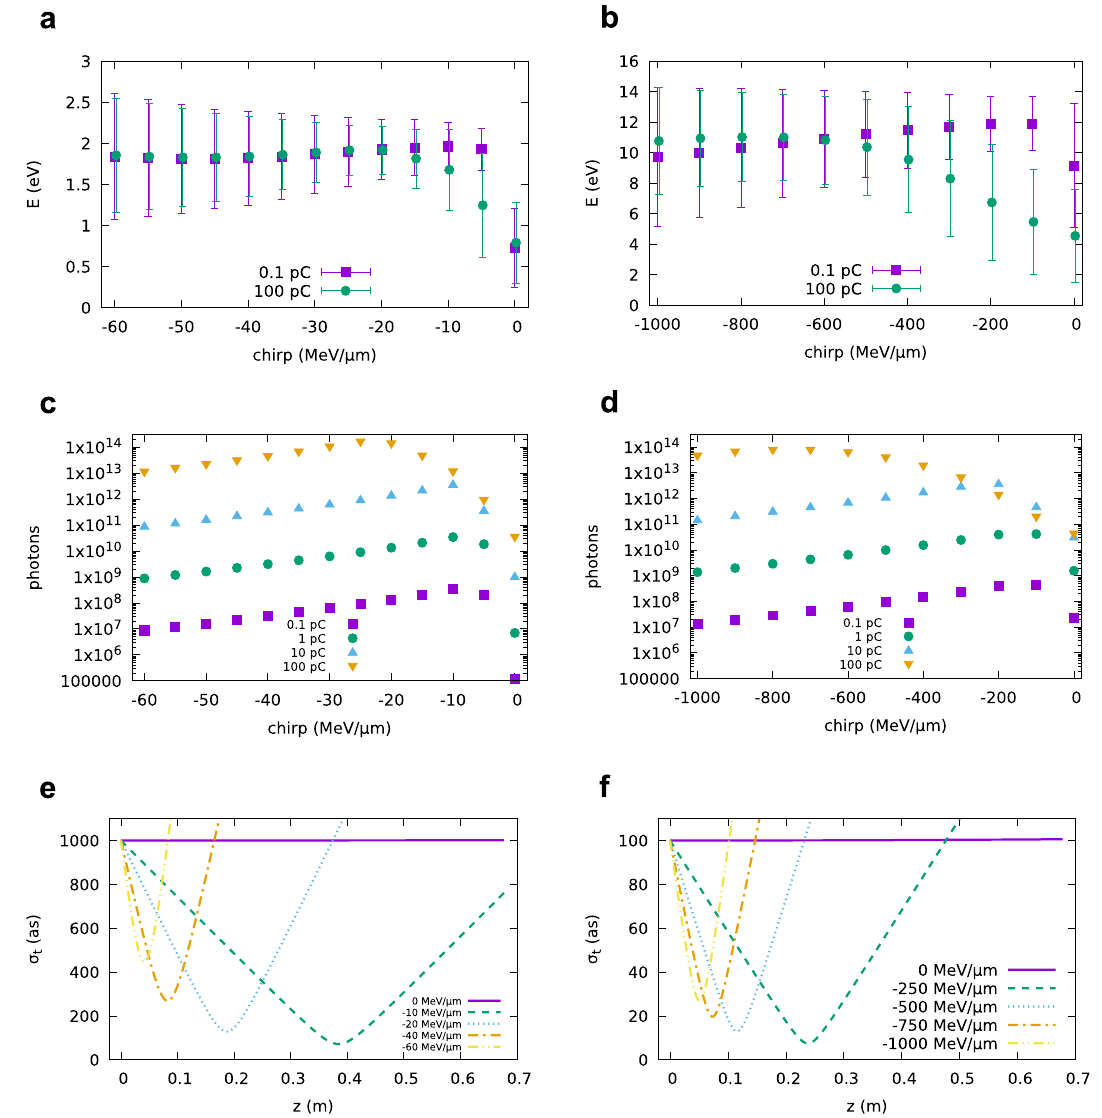
and 100 pC and varying linear chirp. Figures ( a , c , e ) show results for 100 MeV energy and 1 fs initial bunch duration. Figures ( b , d , f ) show results for 250 MeV energy and 100 as initial bunch duration. Radiation is calculated 1 m from the undulator exit in a 10 mm × 10 mm area. ( a , b ) Mean photon energy and r.m.s. bandwidth (error bars) of undulator radiation integrated between 0.1 and 10 eV. ( c , d ) Number of photons with energy 0.9 E 1 < E < 1.1 E 1 . ( e , f ) GPT simulations showing the evolution of the bunch duration in vacuum for different chirp rates and space-charge